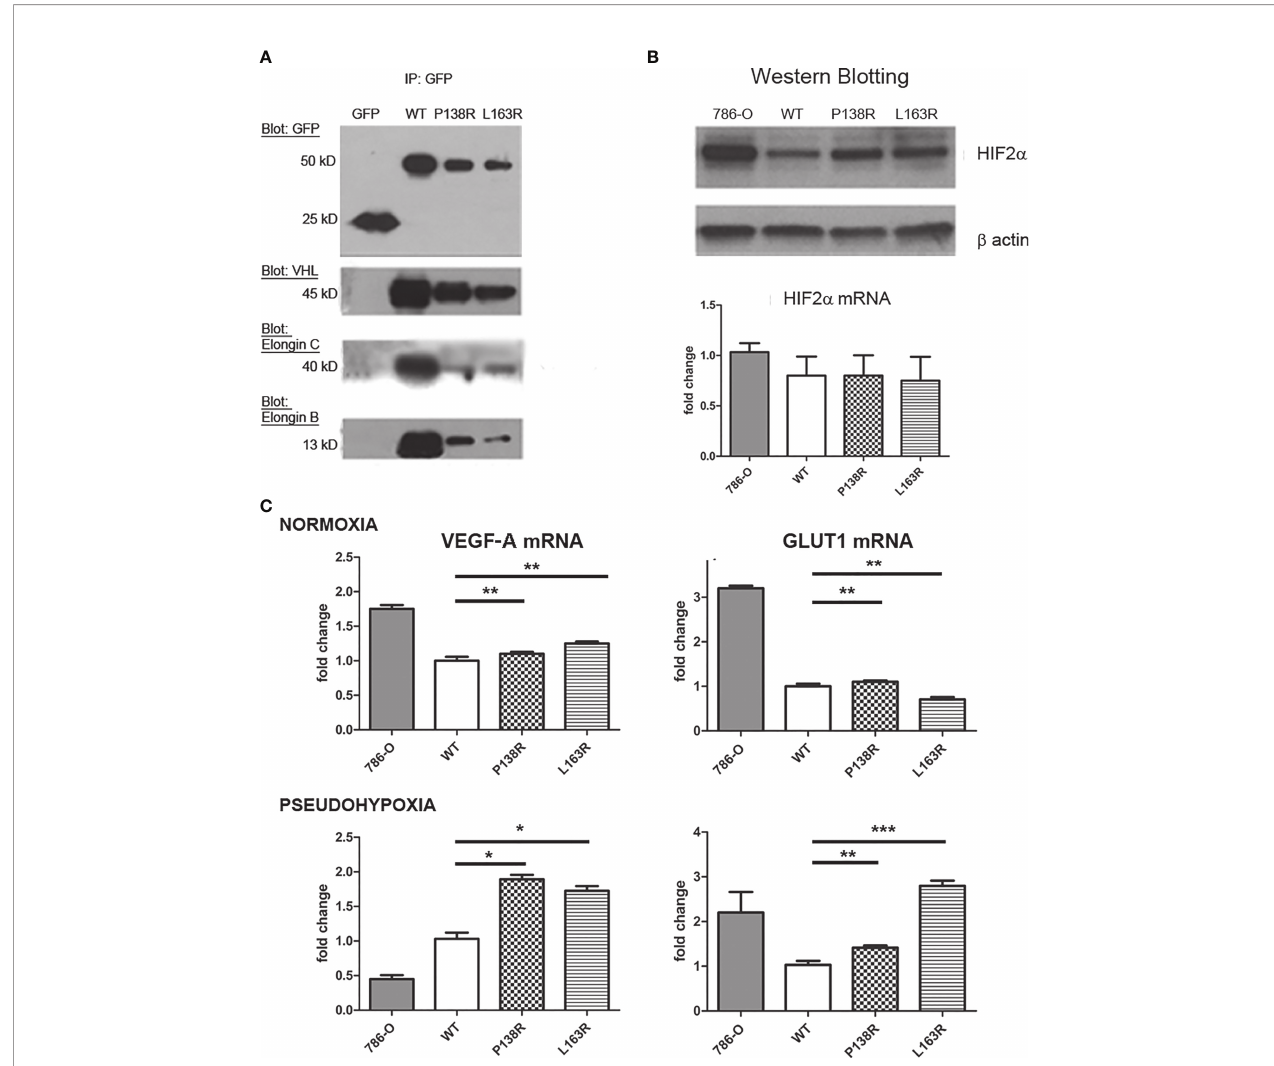
FIGURE 2 | P138R and L163R pVHL variants formless VBC complexes without losingfunctionality. (A) Representative Western blot showing immunoprecipitation ofGFP- trap for each cellline expressing GFP, VHL-WT, P138R, or L163R.Membranes were blotted with anti-GFP, anti-VHL,anti-Elongin C, and anti-ElonginB. (B) Representative Westernblot showingthe levelsofHIF-2 a protein andmRNA measured by RT-qPCR and graphed as foldchange for 786-O,WT, P138R, and L163R celllines. (C) VEG-F and GLUT1 mRNA expression was calculated byRT-qPCR under normoxiaor24 h ofpseudohypoxia generated with 100 µM CoCl 2 . Results are presented as foldchange relative to pVHL WT expression. ns, not signi fi cant; *p < 0.0001, **p = 0.0401, ***p = 0.0002, one-way ANOVA and Tukey ’ s